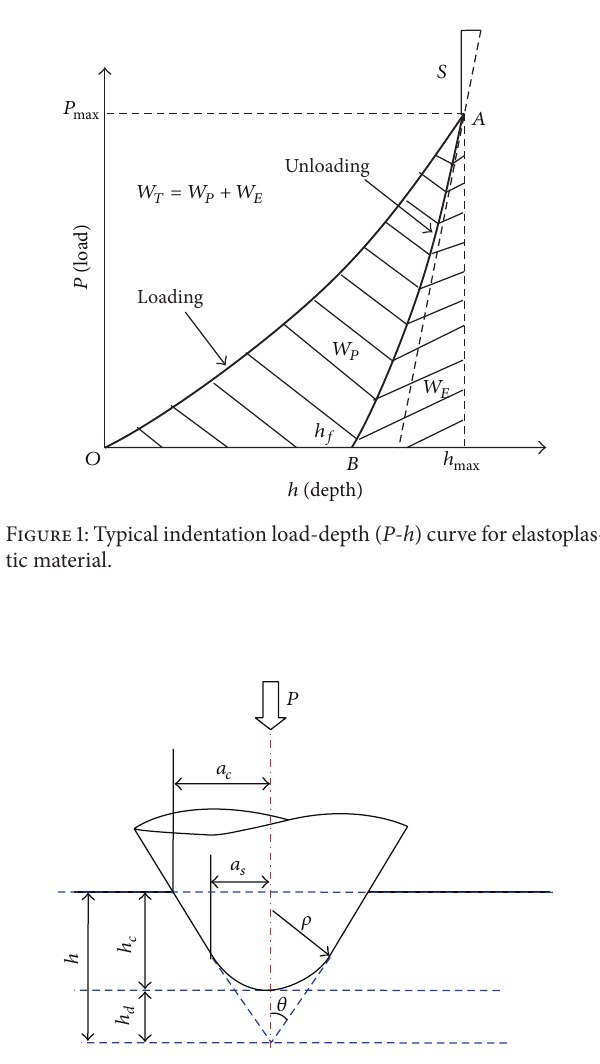
Figure 2: Schematic of the imperfect conical indentation